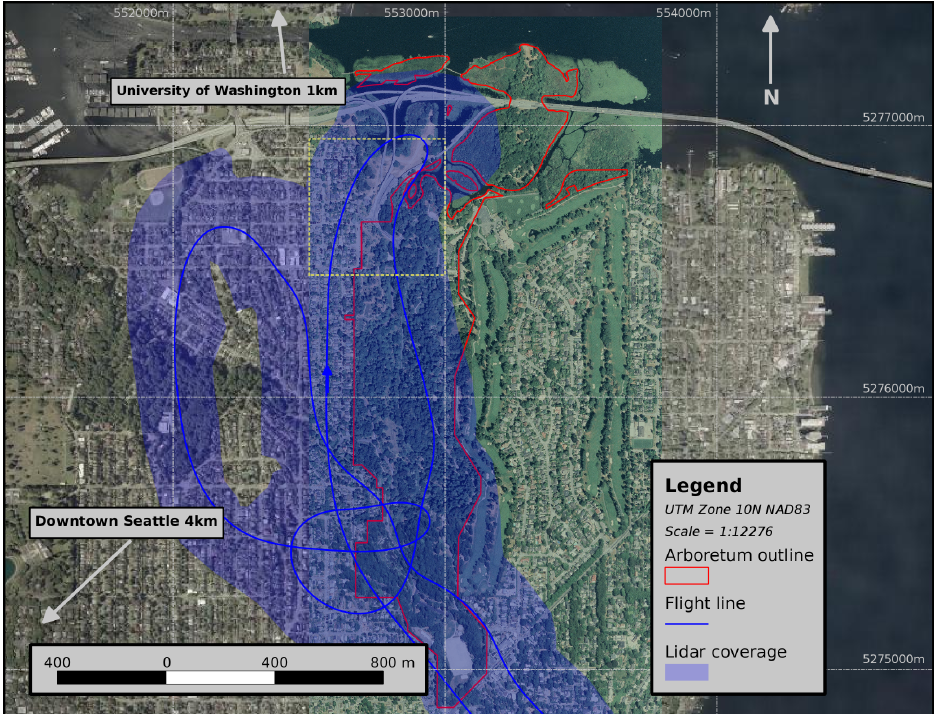
Figure 2. A map of the University of Washington Arboretum in the city of Seattle. The Arboretum boundary is shown as a red line. The helicopter flight path is plotted as a blue line and the associated Lidar coverage area is